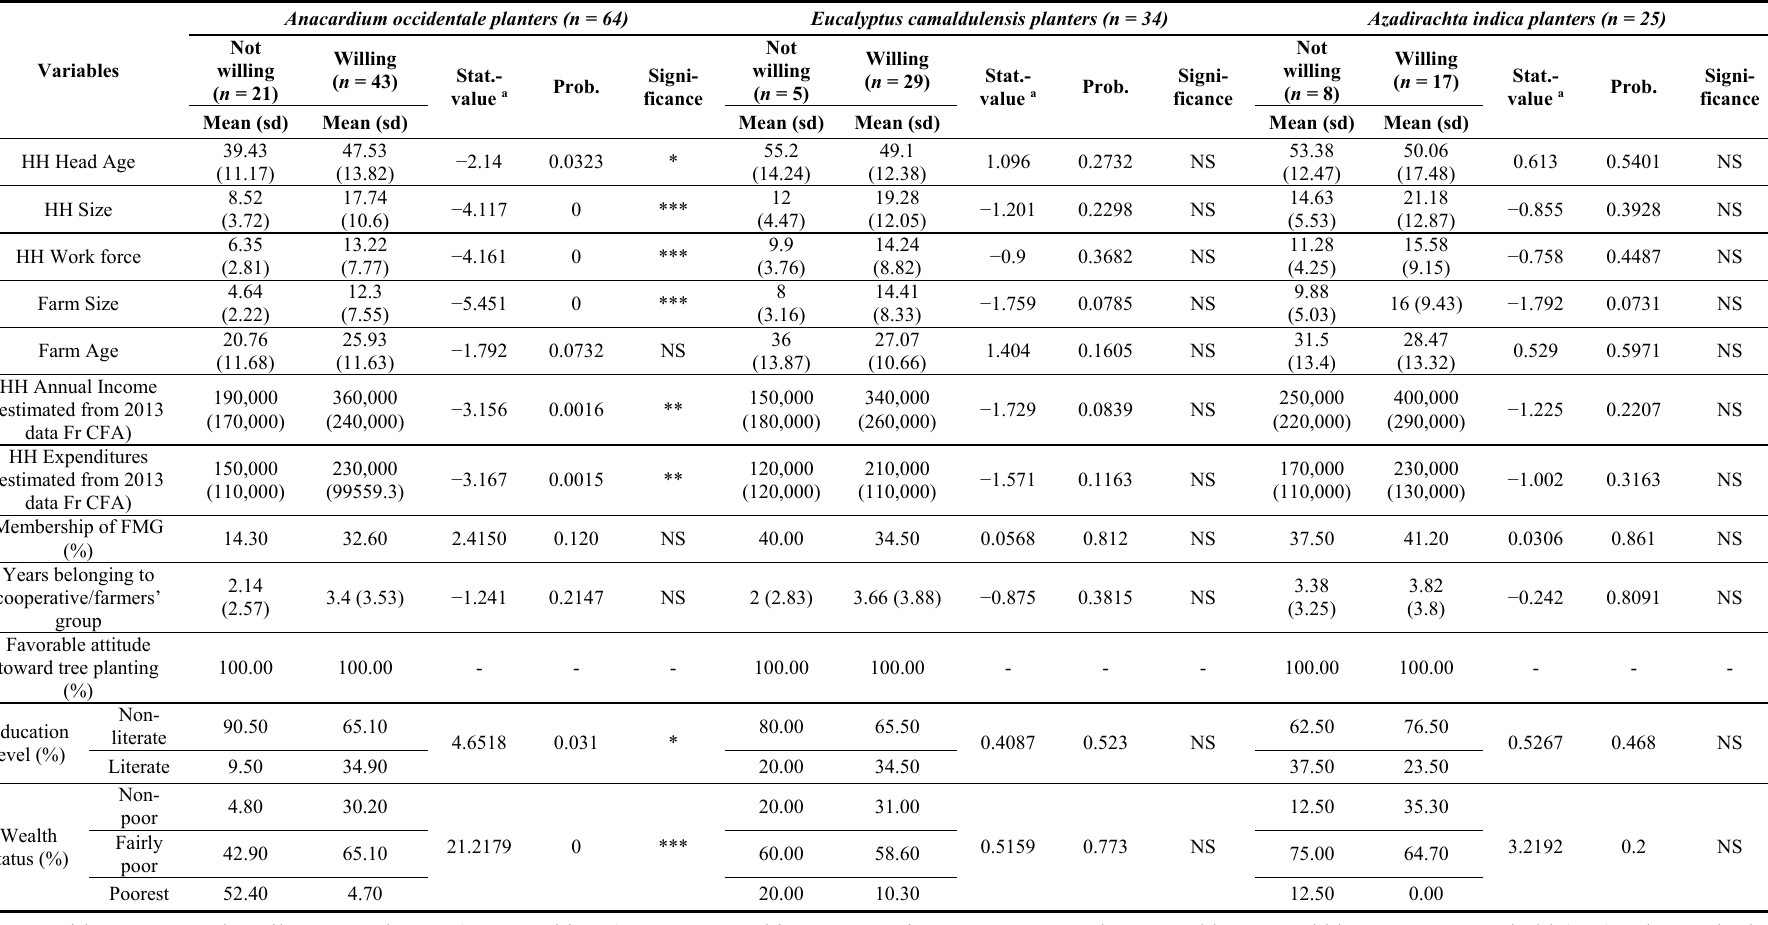
Table 5. Socio-economic and perceptional characteristics of tree planters that were willing or not willing to continue planting Anacardium occidentale, Eucalyptus camaldulensis and Azadirachta